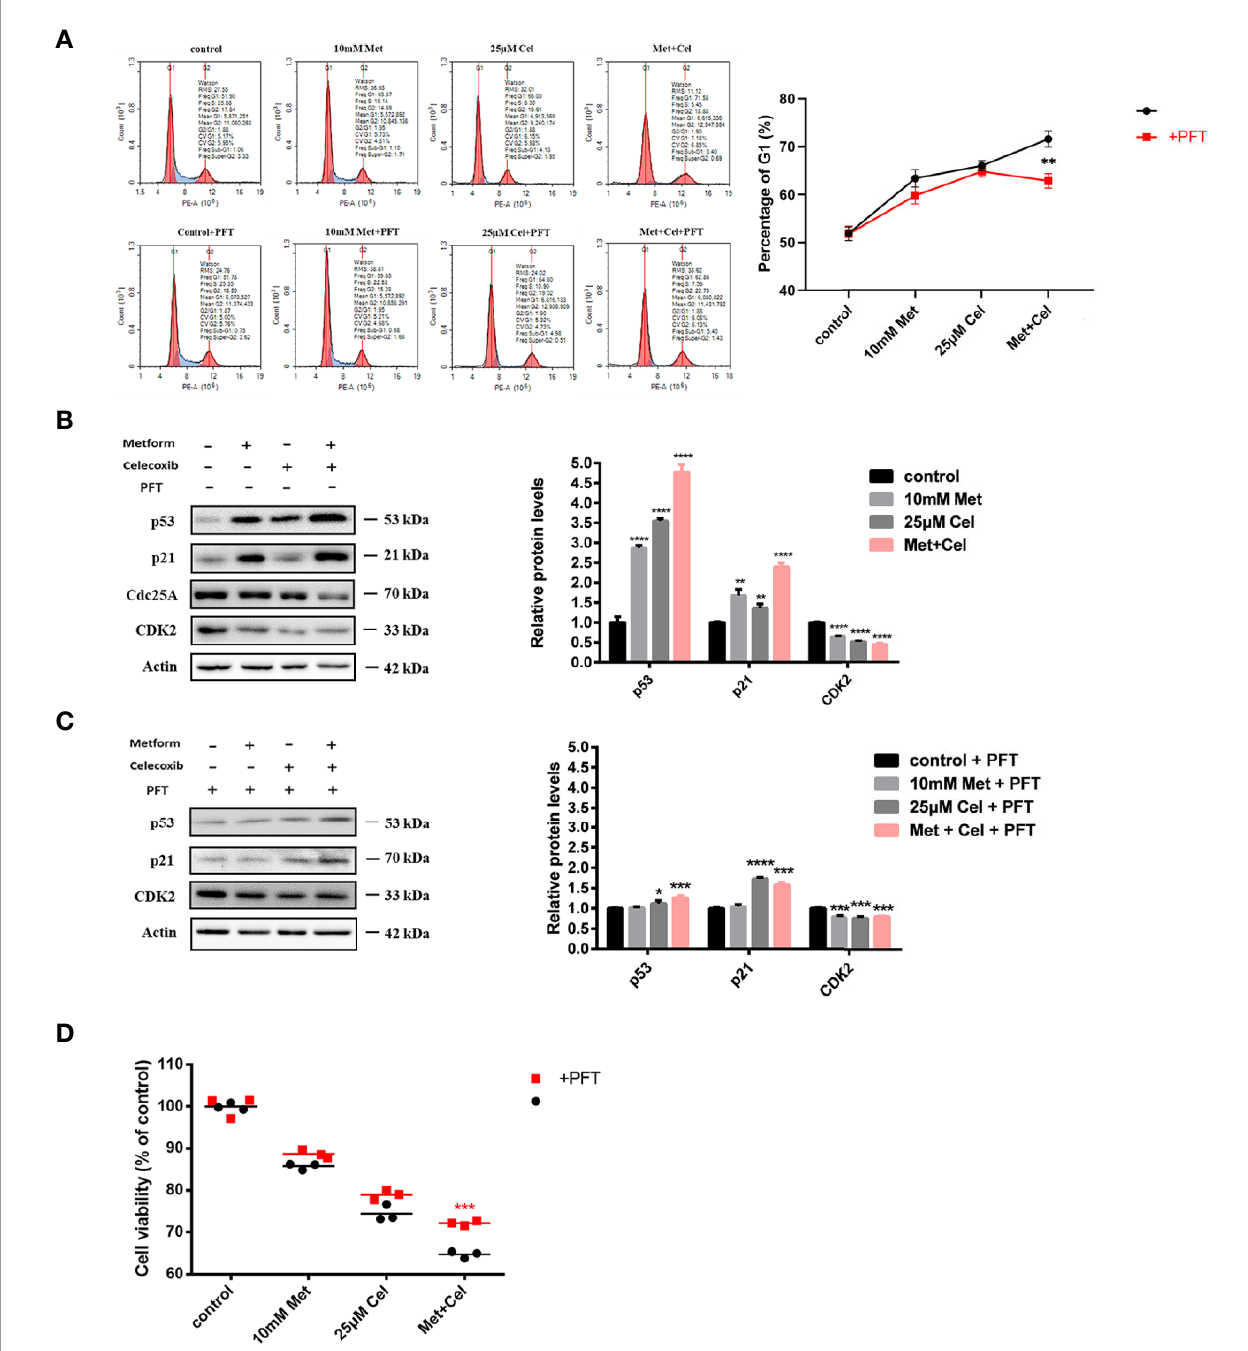
FIGURE 5 | Combined treatment with celecoxib and metformin acts on p53 to arrest cell cycle in the G1 phase and enhance antiproliferative response. (A) Cell cycle analysis of A549 treated with 10 mM metformin and/or 25 m M celecoxib for 48 h with the absence or presence of 5 m M PFT. Quanti fi cation of the proportion of the cells in the G1 phase was shown in the right panel. (B) Western blotting analysis of p53, p21, Cdc25A, CDK2 protein levels of A549 cells treated with 10 mM metformin and/or 25 m M celecoxib for 48 h. Band intensity was quanti fi ed by Image J software. (C) Western blot analysis of p53, p21, Cdc25A, CDK2 protein levels of A549 cells treated with 10 mM metformin and/or 25 m M celecoxib for 48 h in the presence of 5 m M PFT. Band intensity was quanti fi ed by Image J software. (D) Cell viability analysis of A549 cells treated with 10 mM metformin and/or 25 m M celecoxib for 48 h in the absence or presence of 5 m M PFT. Data are represented as mean ± SD. * p < 0.05, ** p < 0.01, *** p < 0.001, **** p <